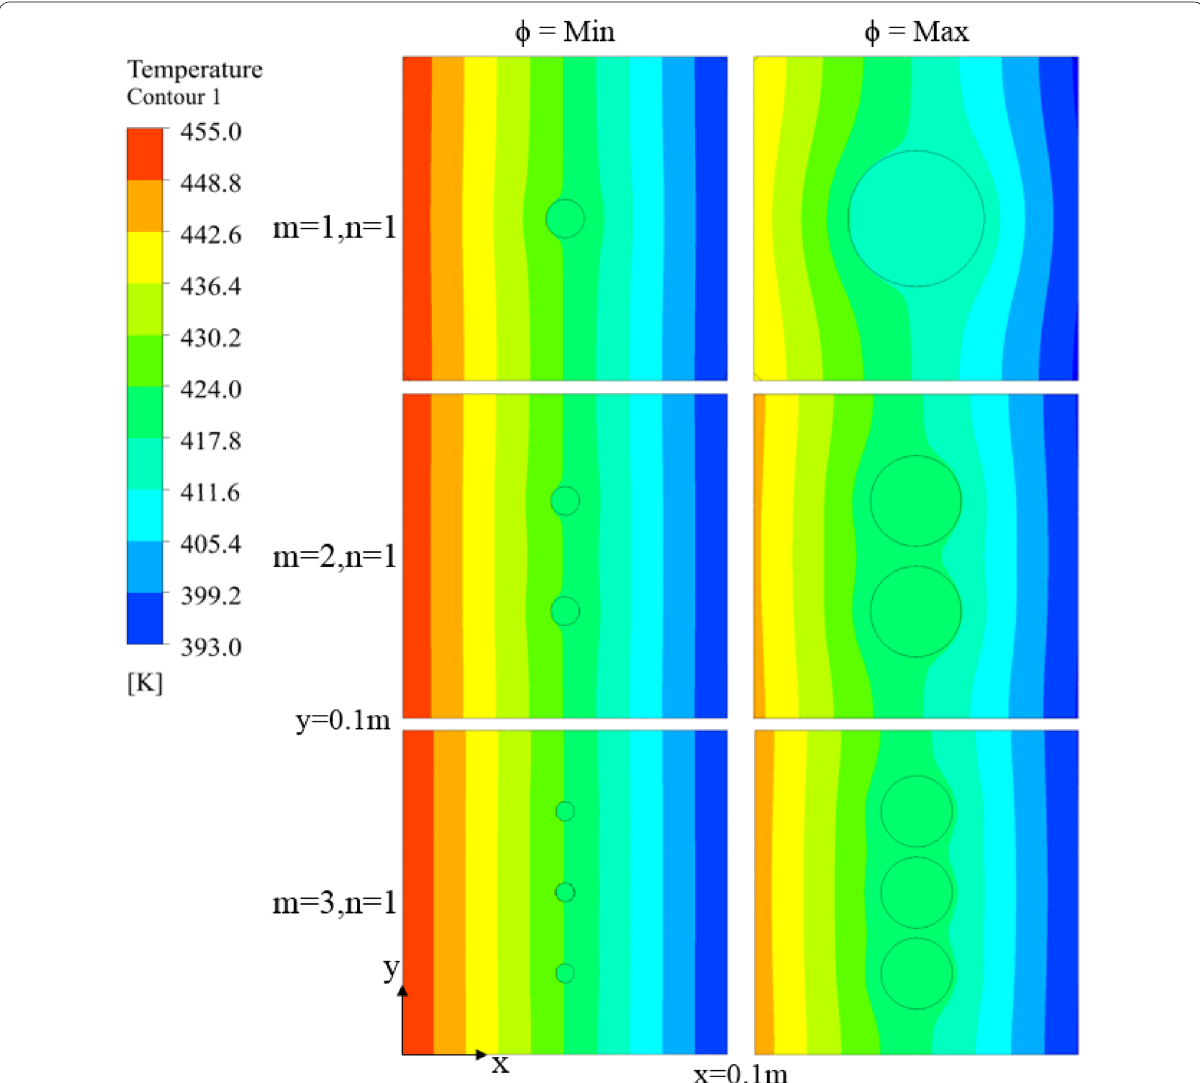
Fig. 7 Temperature distributions of reinforced concrete arranged in the normal heat transfer direction at the center cross sections of x–y plane in the volume fraction of minimum and